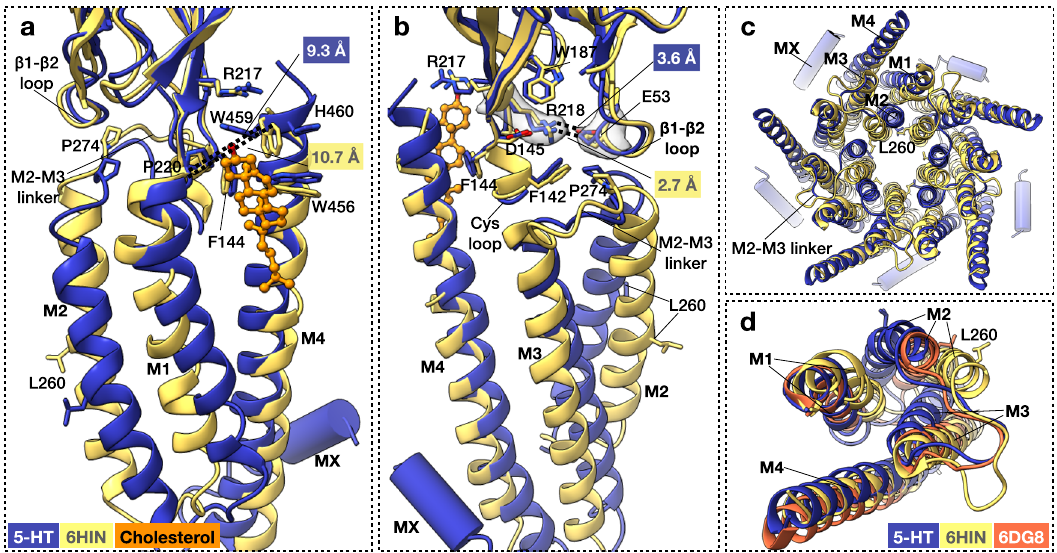
Fig. 6 Comparison of serotonin-bound 5HT 3 R-Salipro and 6HIN structures. a , b Superposition of the serotonin-bound 5HT 3 R-Salipro (chain C) and 5HT 3 R-detergent (6HIN) 17 structures at a the cholesterol-binding pocket viewed from the membrane (M3 is omitted for clarity) or b at the Cys loop, β 1- β 2 loop, M2 – M3 linker junction viewed from the neighbouring subunit (M1 and part of the Cys loop and TMD are omitted for clarity). Distances are labelled in the same colour scheme as the structures. Density sharpened using RELION with auto-determined b-factor, shown in transparent grey for residues R218 and E53, at σ 6.5. c , d Top views of the TMD, with d including the 5HT 3 R-detergent 6DG8 structure and showing single subunits only for